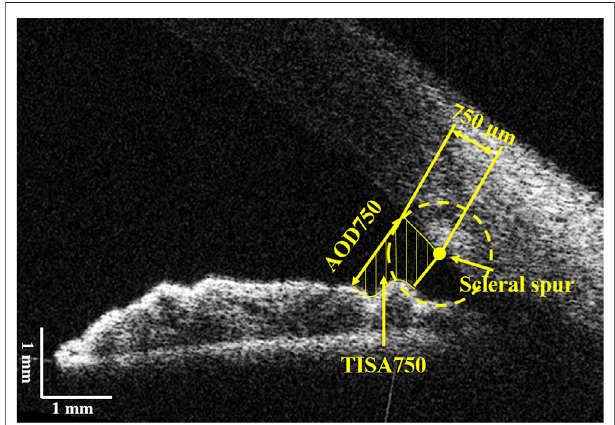
FIGURE 2 | Illustration of the anterior chamber parameters. AOD750, angle opening distance at 750 μ m from the scleral spur; TISA750, trabecular- iris space area at 750 μ m from the scleral